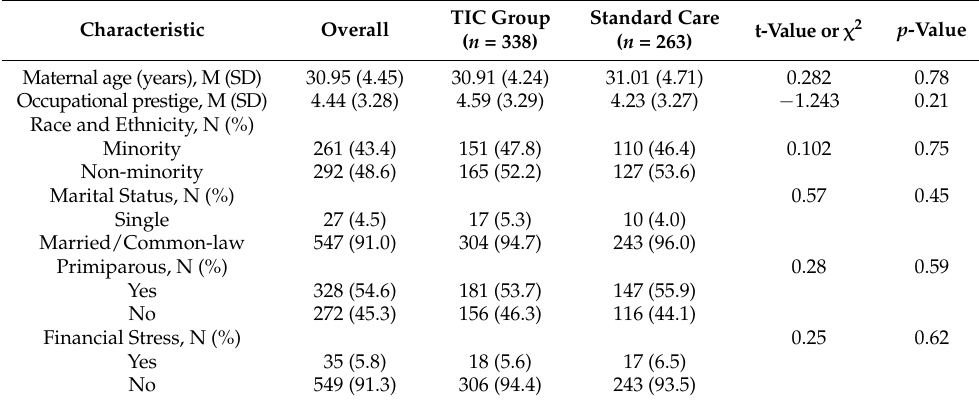
Table 1. Demographic characteristics for the trauma-informed care (TIC) versus standard care groups.